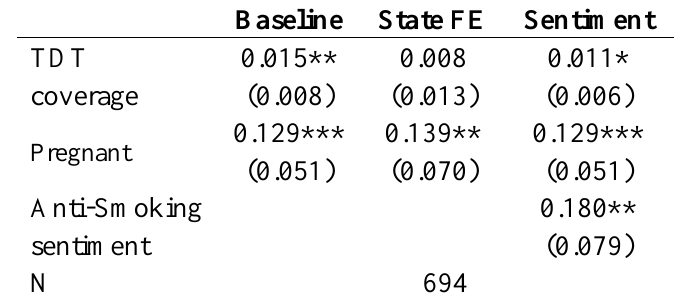
Table 4. Probit model of smoking cessation, age 18–44 women, controlling for